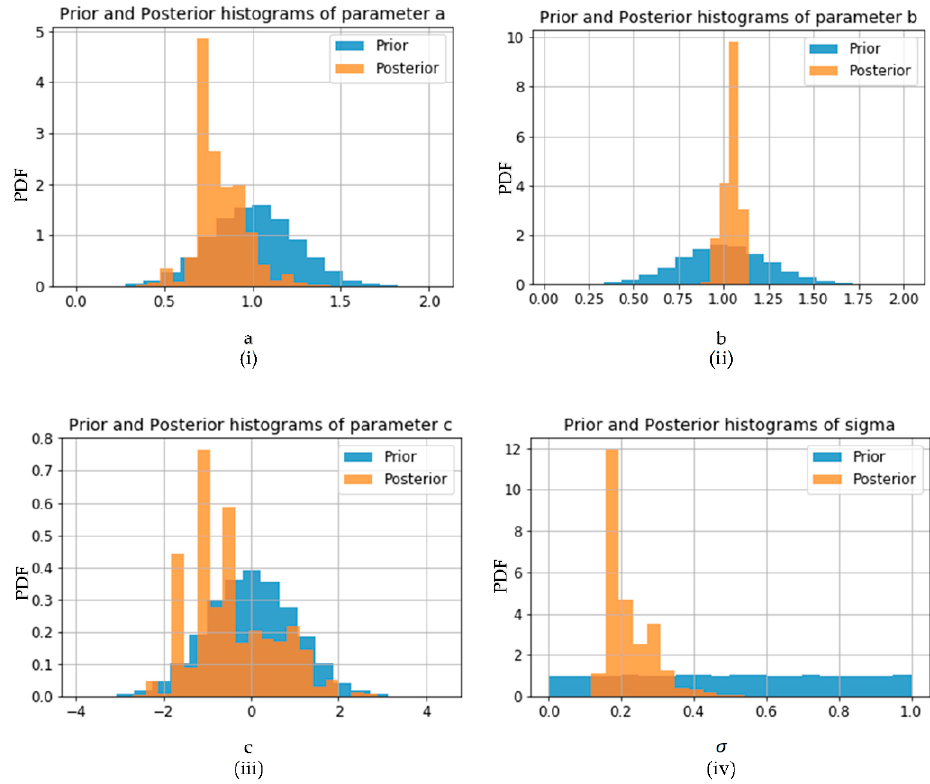
Figure 12. Prior and posterior histograms of ( i ) parameter a, ( ii ) parameter b, ( iii ) parameter c, and ( iv ) standard deviation associated with error ( σ ) .